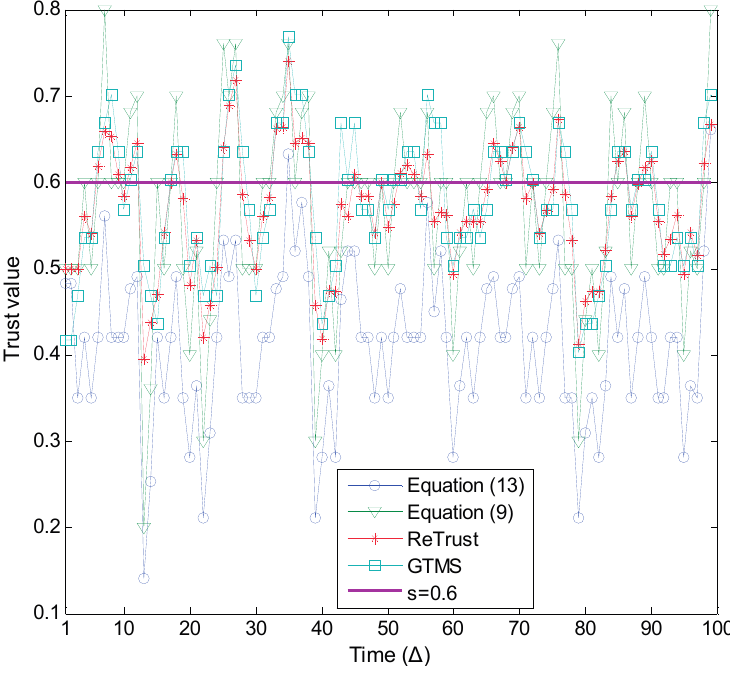
Figure 6. Misbehavior detection ( p ≥